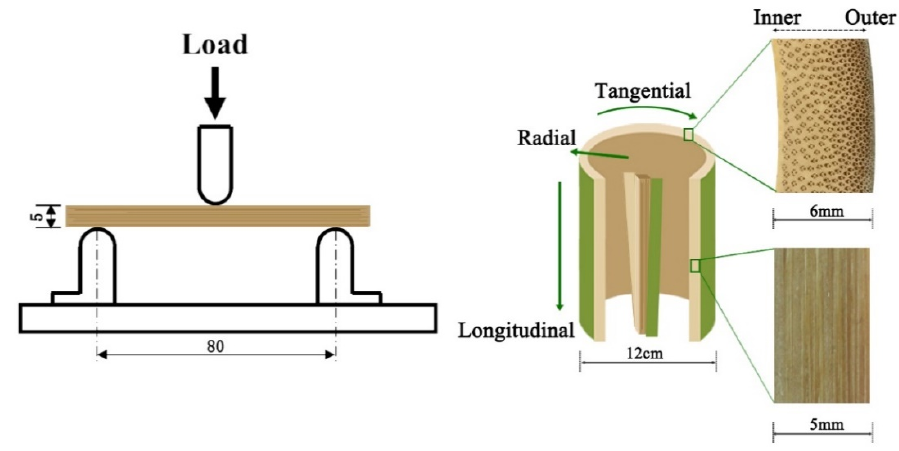
Figure 1. The hierarchical structure of moso bamboo.